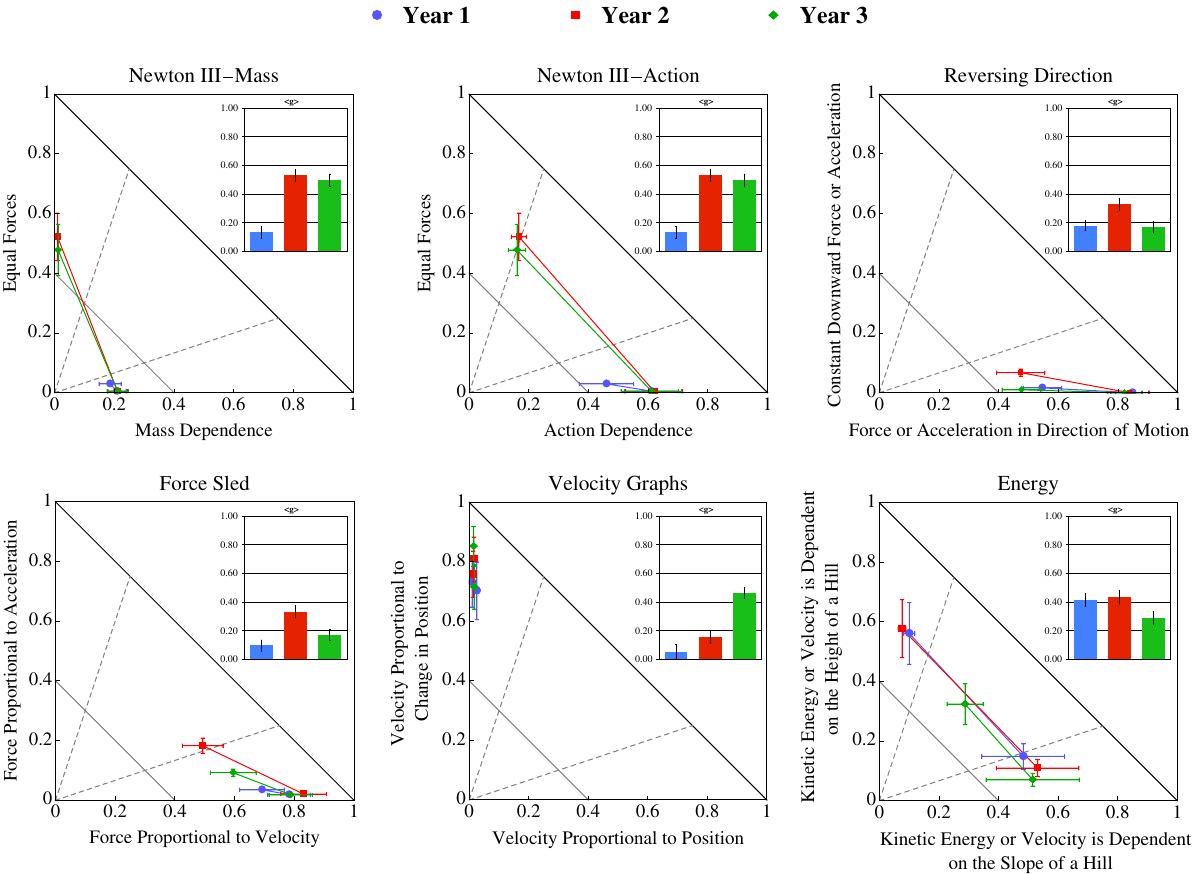
FIG. 4. Model analysis plots of FMCE data from school 1. Normalized gain plots for each cluster are included to allow for easier comparison of representations. Plots for additional question clusters are presented in Appendix